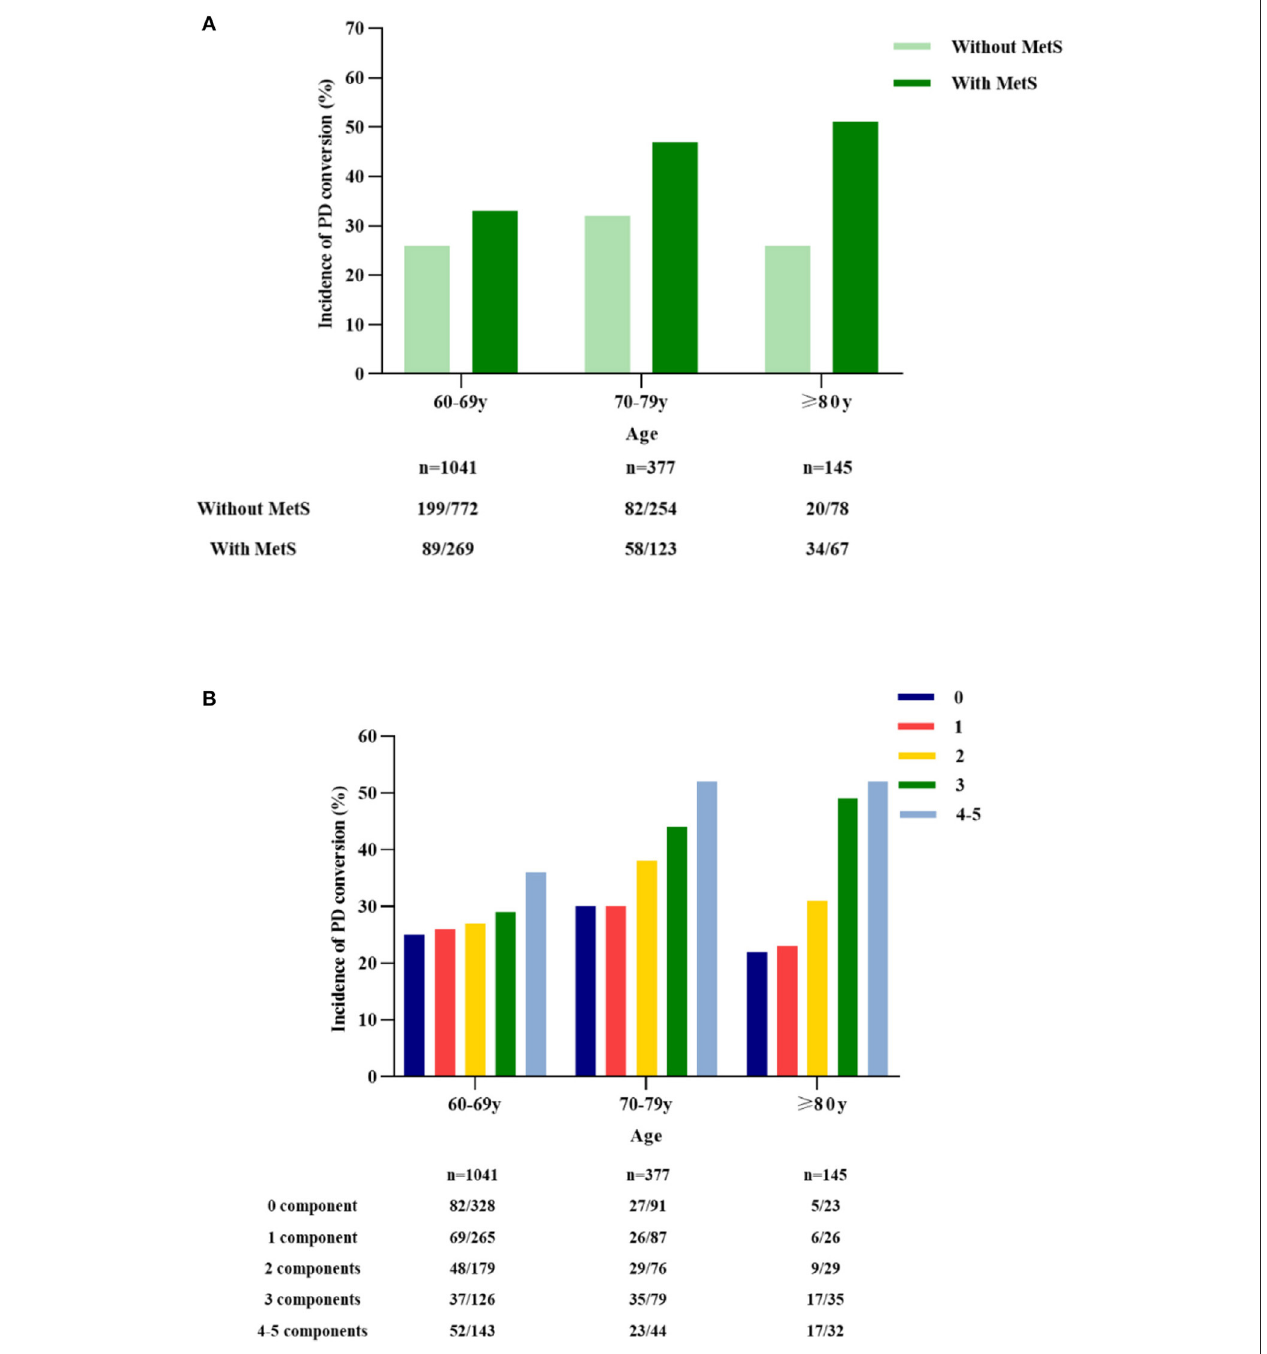
FIGURE 3 | MetS and incidence of PD conversion by age. The participants were divided into three groups according to age: 60–69 years old, 70–79 years old, and 80 years and older. The incidence of PD conversion was significantly higher in participants with metabolic syndrome than in those with non-metabolic syndrome in the 60–69, 70–79, and 80 years and older age groups ( P < 0.05; P < 0.01; A ). The incidence of PD conversion was analyzed according to the number of MetS components. Compared with the non-metabolic syndrome component, the incidence of PD conversion was significantly higher in participants with three and four to five metabolic syndrome components in the 70–79 and 80 years and older groups ( P < 0.05), and the incidence of PD conversion was significantly higher in participants with four to five metabolic syndrome components in the 60–69 years old group ( P < 0.05; B ). PD, Parkinson’s disease; MetS, metabolic syndrome.